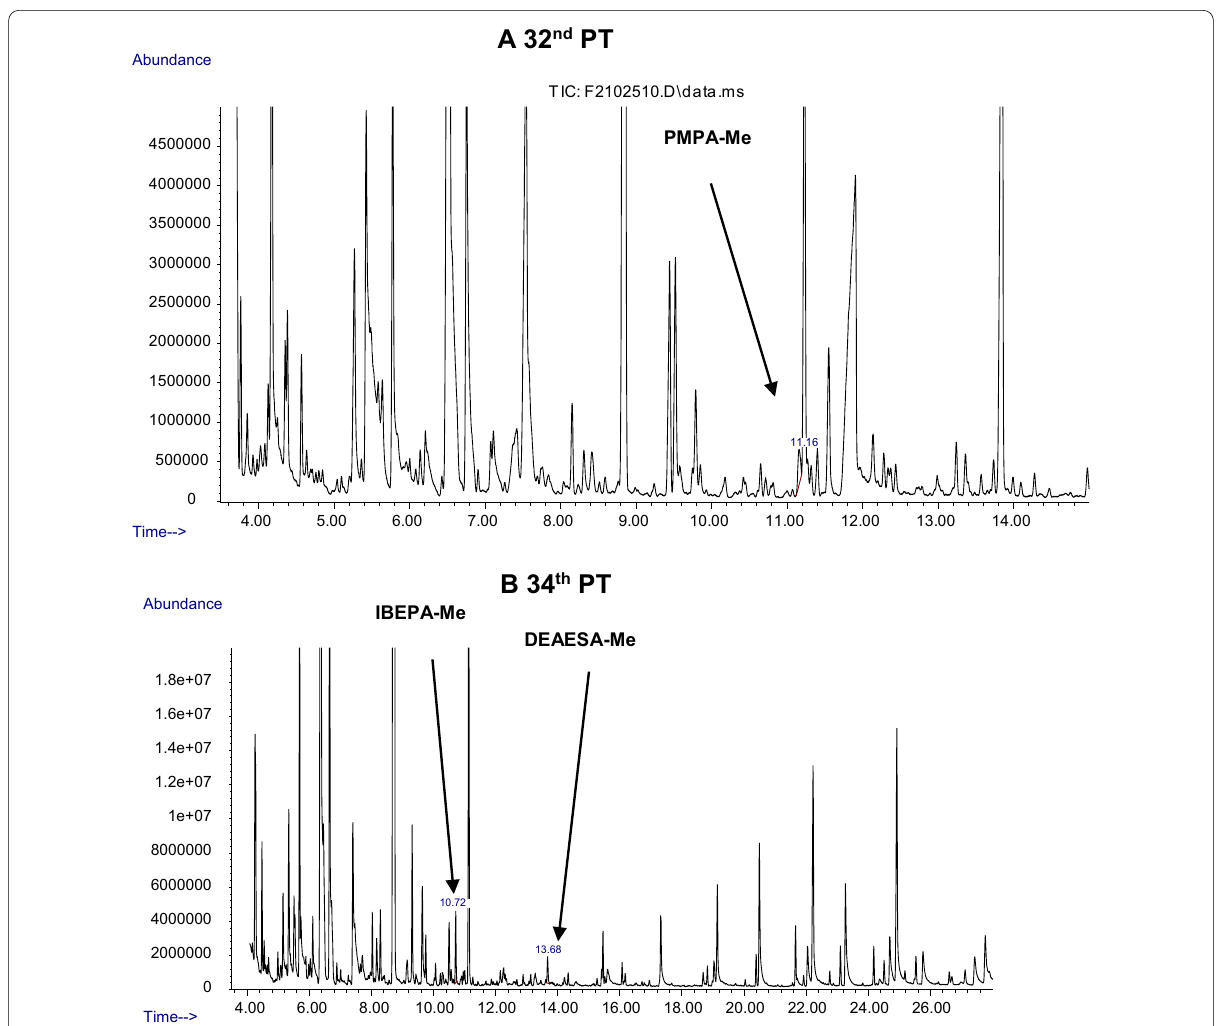
Fig. 8 TICs of GC–MS analysis of water samples of the 32nd ( A ) and 34th ( B ) OPCW PTs. TMSDAM was used for methylation and a DB‑5 ms column for analysis. The methyl derivatives of isobutyl ethylphosphonic acid (IBEPA), DEAESA (both spiked with 10 µg/ml) and PMPA (7 µg/ml) could be